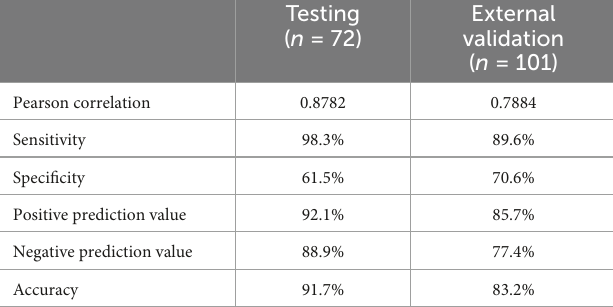
TABLE 2 Model performance and sensitivity